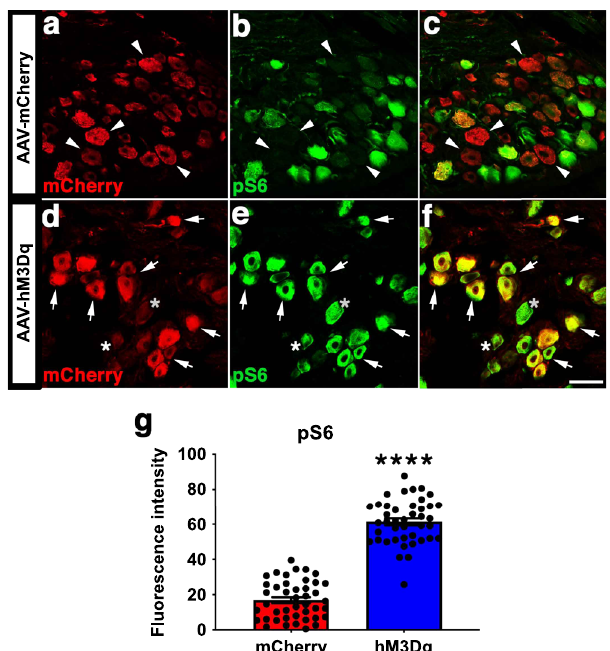
Fig. 10 Chemogenetic neuronal activation increases mTOR activity. DRGs injected with either hM3Dq or mCherry. All animals received CNO. One day after CNO administration, sections were stained for p-S6, a marker of mTOR activation. While some mCherry + neurons had detectable p-S6, many did not ( a – c , arrowheads). However, the vast majority of hM3Dq + DRGs had high levels of p-S6 ( d – f , arrows), even neurons that weakly expressed hM3Dq (asterisks). ( g ) Quanti fi cation of p-S6 fl uorescence intensity. N = 43 mCherry + neurons and 42 hM3Dq + neurons. Mean ± SEM. Two-tailed unpaired t -test, **** p < 0.0001. Scale bar: 70 µ m. Source data are provided as a Source Data fi